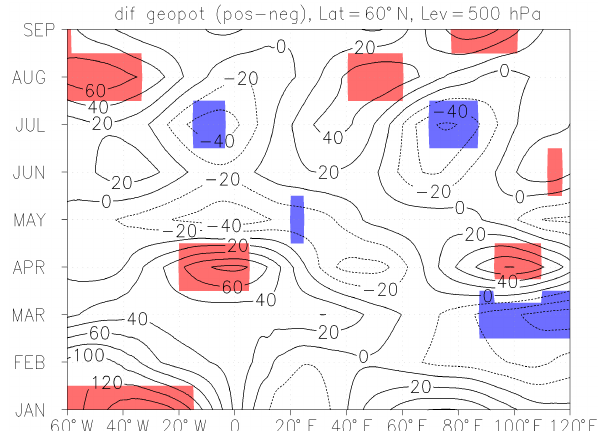
Figure 5. Evolution of 500hPa height differences between mild and cold winters at 60 ◦ N; red and blue shading indicates differences at the 95% significance levels for positive and negative height, respec-